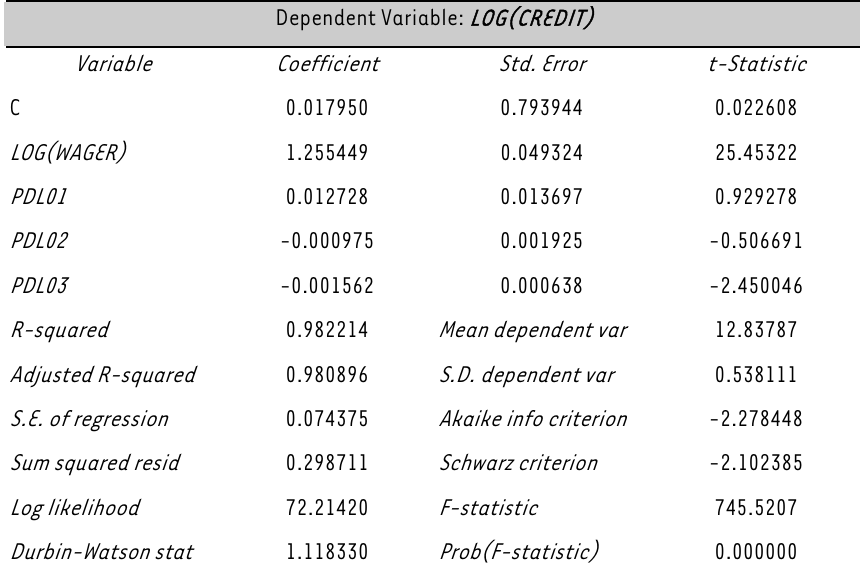
TABLE 1: Regression results for